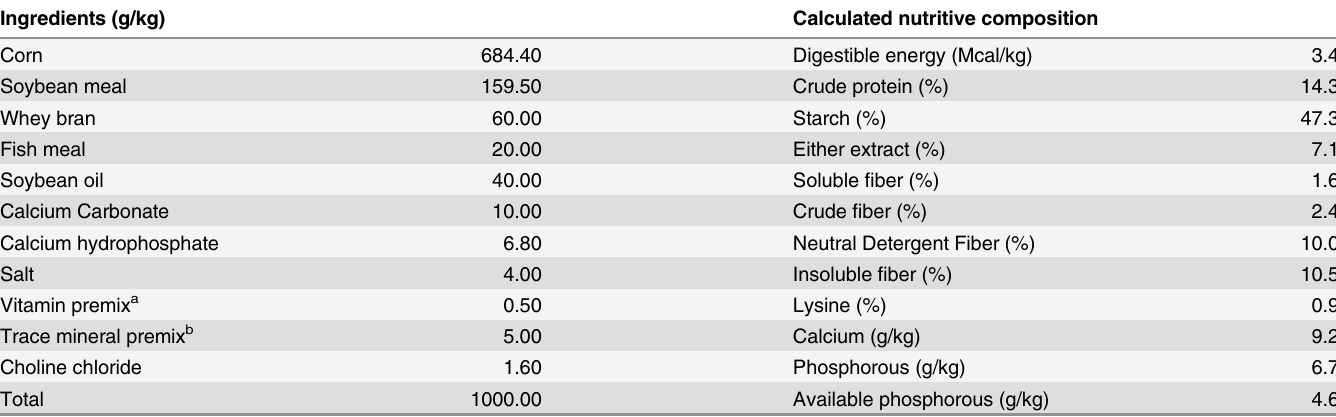
Table 1. Diet composition and nutrient levels (90% Dry matter basis,